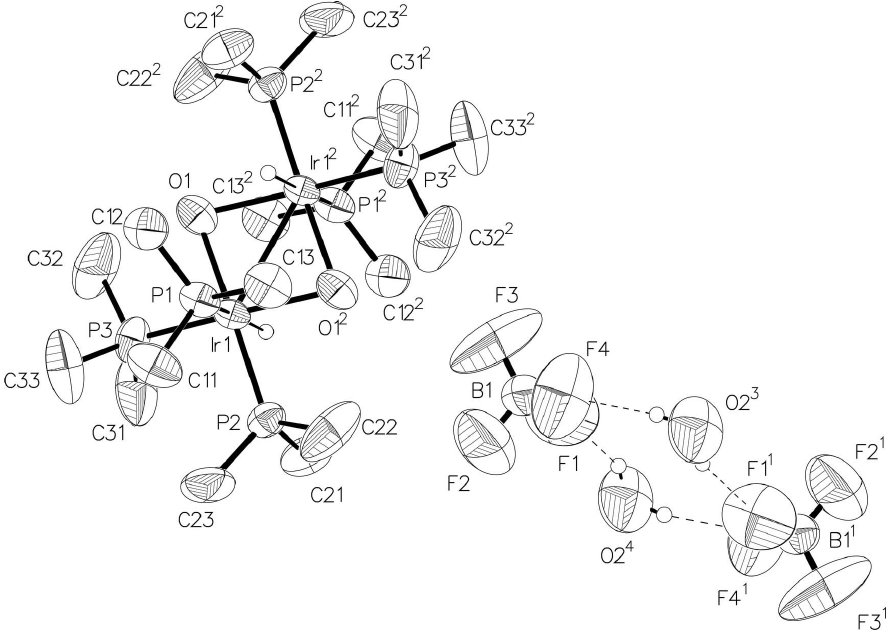
Figure 1 Thermal ellipsoid plot of the structure with ellipsoids drawn at the 50% probability level. Atoms are labeled with superscripts to indicate the symmetry operator that generated them. A 1 : – X ,-Y,2- Z , A 2 : 1- X ,1-Y,1- Z , A 3 : -1+ X ,+Y,1+ Z , A 4 : 1- X ,-Y,1- Z